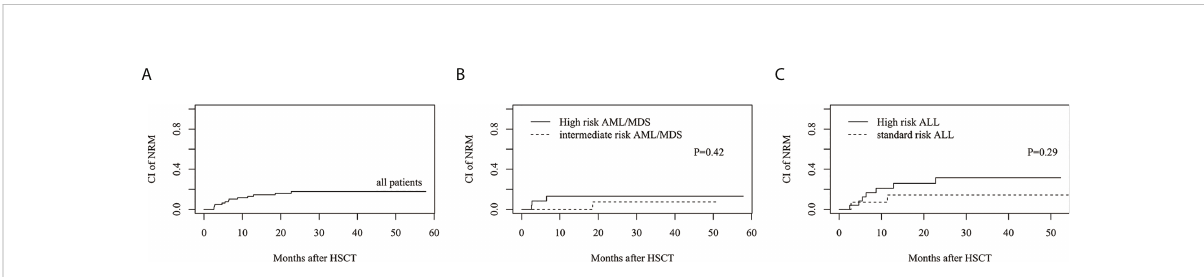
FIGURE 4 The estimated CI of non-relapse mortality (NRM). (A) NRM in all patients. (B) NRM between intermediate risk AML/MDS and high risk AML/MDS. (C) NRM between standard risk ALL and high risk